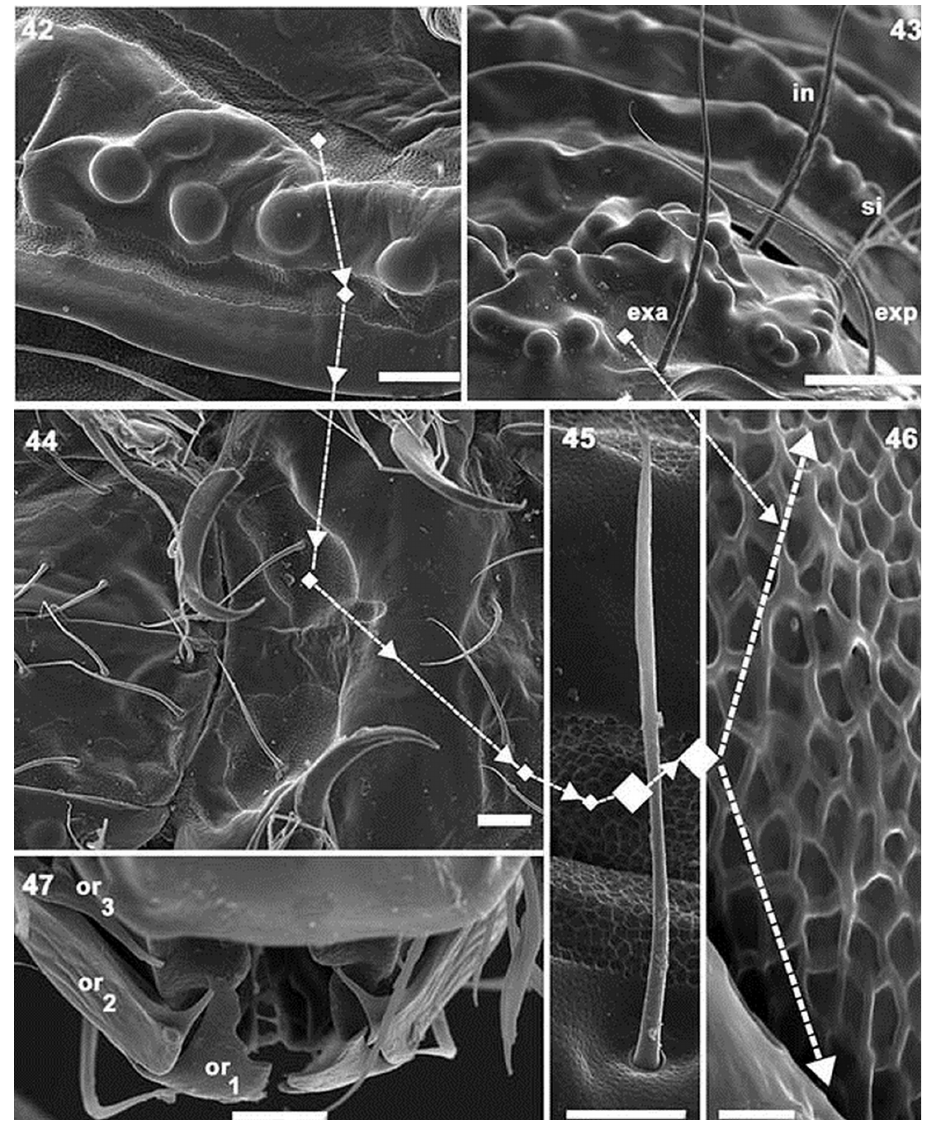
Figures 42–47. Paulianacarus costaricensis sp. n. Adult with cerotegumental layer. SEM. 42 lateral view, notogastral promontories 43 Frontal prodorsum detail promontories 44 epimeral posterior zone 45 notogastral setae and microsculpture, “porose area” 46 depressed area microsculpture, notogastral zone 47 adoral setae, frontal view. Abbreviations: See Material and methods. Scale bars: 42 = 20 μm; 43 = 50 μm; 44 = 20 μm; 45 = 10 μm; 46 = 2 μm; 47 = 10